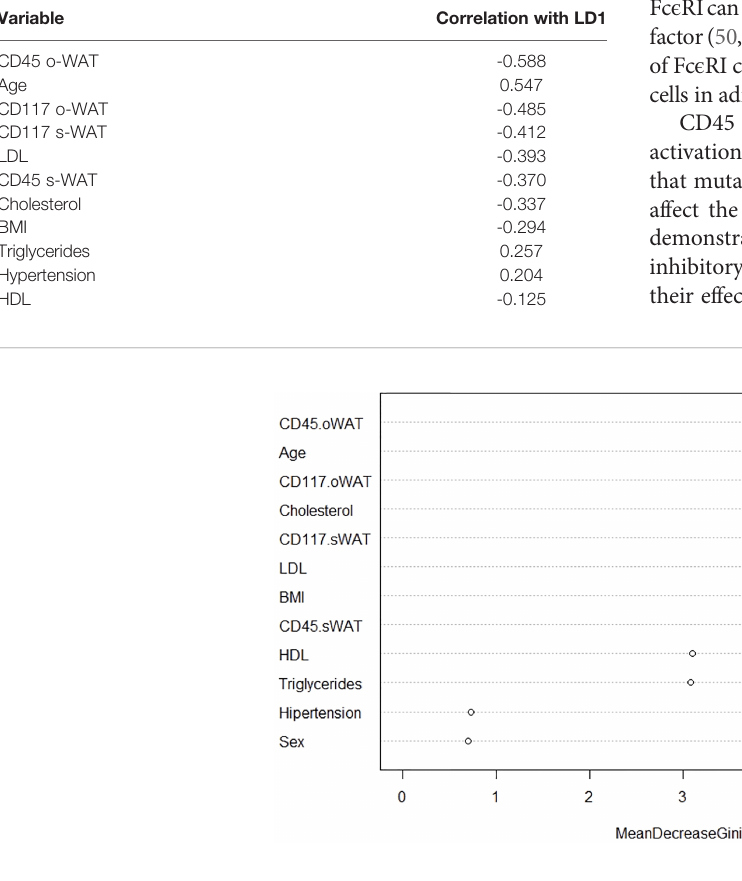
FIGURE 10 | Random Forests Analysis. This method measures the relevance of the variables to discriminate the three levels of the categorical variable “ Type 2 diabetes ” . BMI (body mass index), o-WAT (omental white adipose tissue), s-WAT (subcutaneous white adipose tissue).